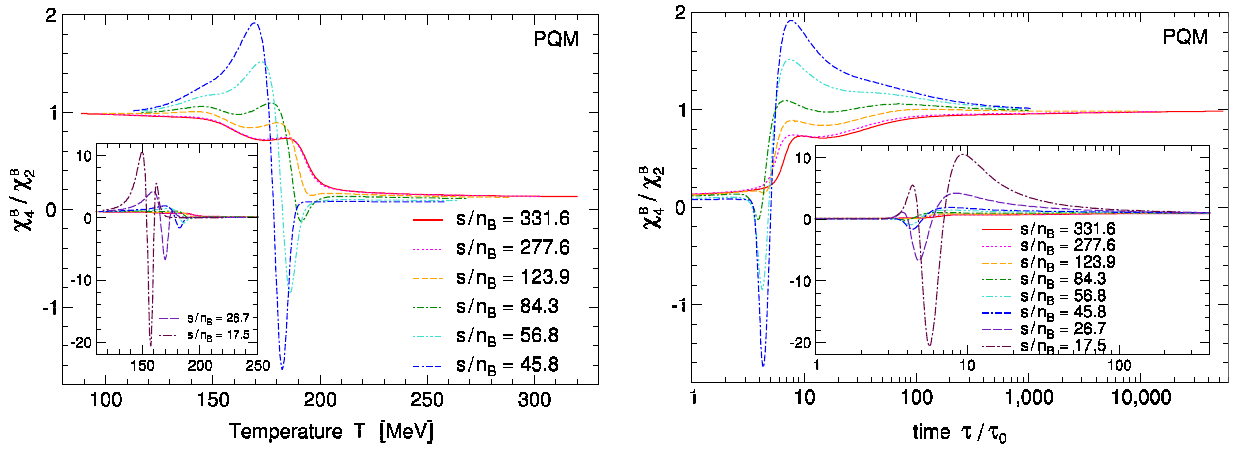
Fig. 11 The same as in Fig. 10, but for the PQM